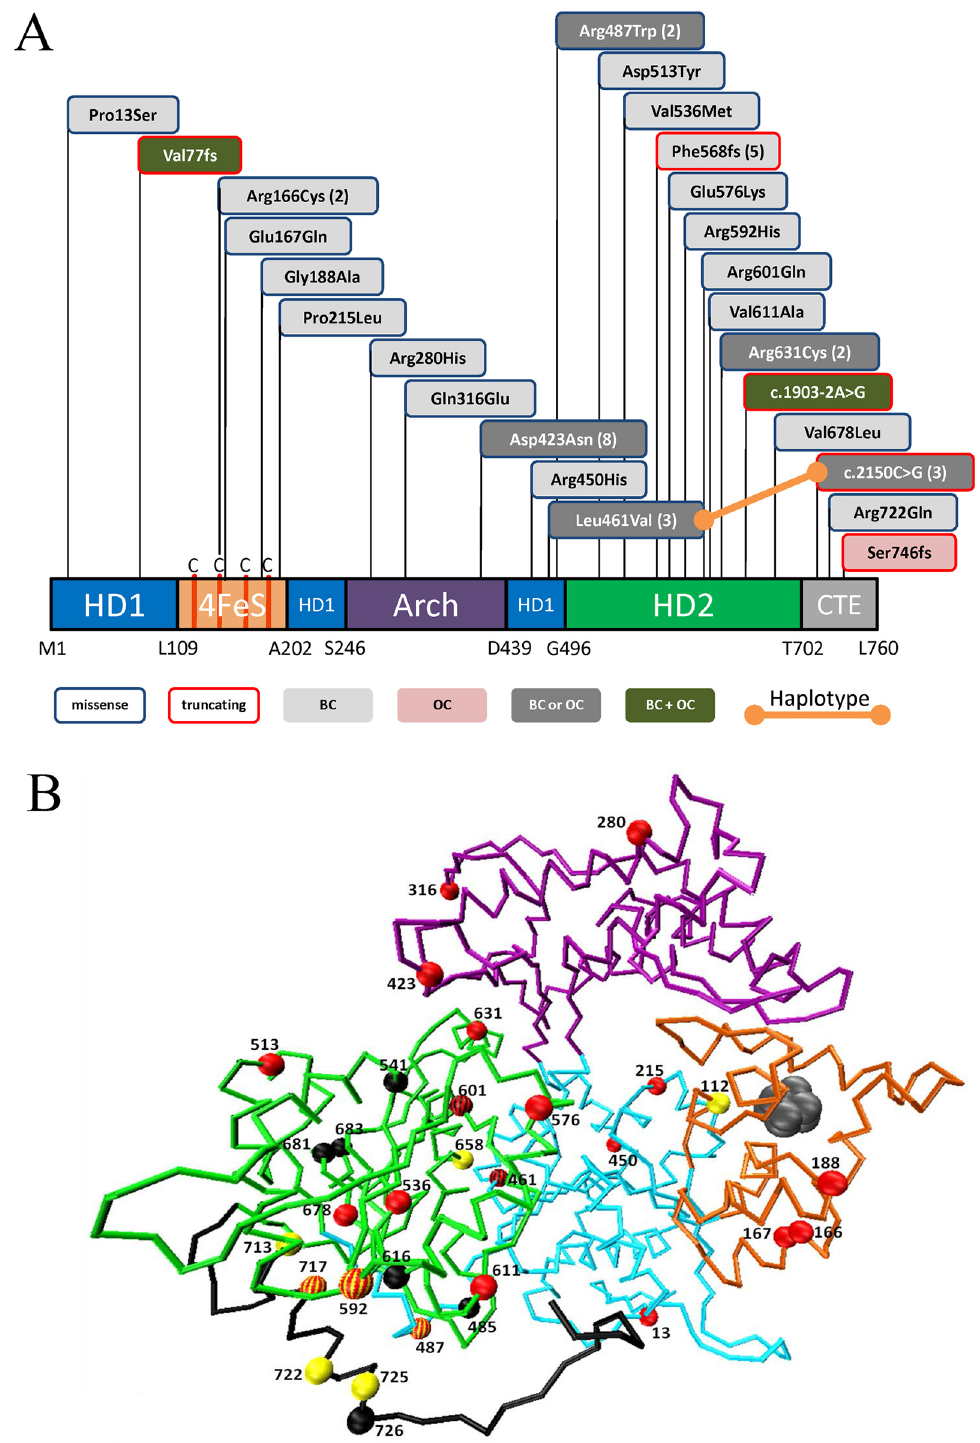
Fig 1. Domain structure and modeling of the ERCC2 mutations. (A) Mutations in the XPD/ERCC2 protein domains. The diagram shows the ERCC2 protein with the four XPD domains shown as HD1 (blue), HD2 (green), FeS (Orange) and Arch (purple). The human enzyme has a C-terminal (grey) extension (CTE) that probably forms an interaction surface with the p44 protein. Disease-relevant ERCC2 mutation sites are indicated in boxes (blue or red frame: missense or truncating mutation, respectively; fillings: light-gray, cases with breast